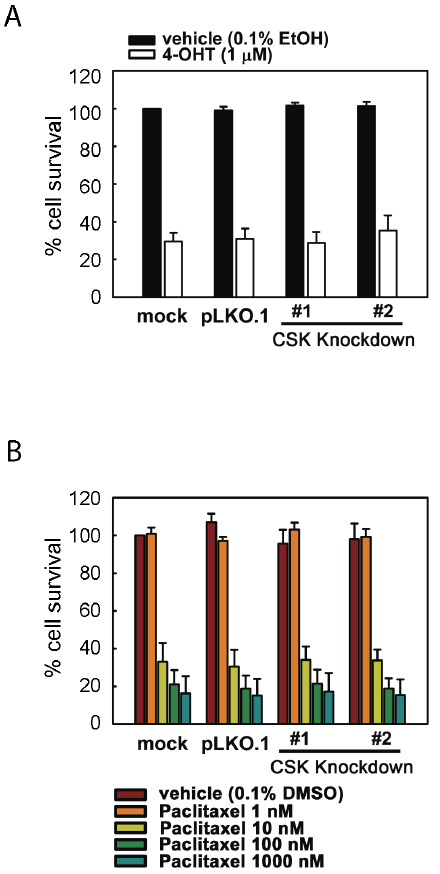
Figure 2. RNAi knockdown of CSK does not affect MCF-7 cell sensitivity to tamoxifen or paclitaxel. Cells were infected with empty lentivirus vector (pLKO.1) or two independent clones of lentiviruses expressing different shRNA species targeting CSK shown in Figure 1 (CSK KD # 1 and # 2) and then exposed to 1 m M 4- hydroxytamoxifen (4-OHT) for 10 days (A) or 1–1000 nM paclitaxel for 2 days (B). Cell viability was determined by crystal violet staining (Fig. S3) and quantified by spectrophotometry (mean 6 SEM of three or more independent experiments).